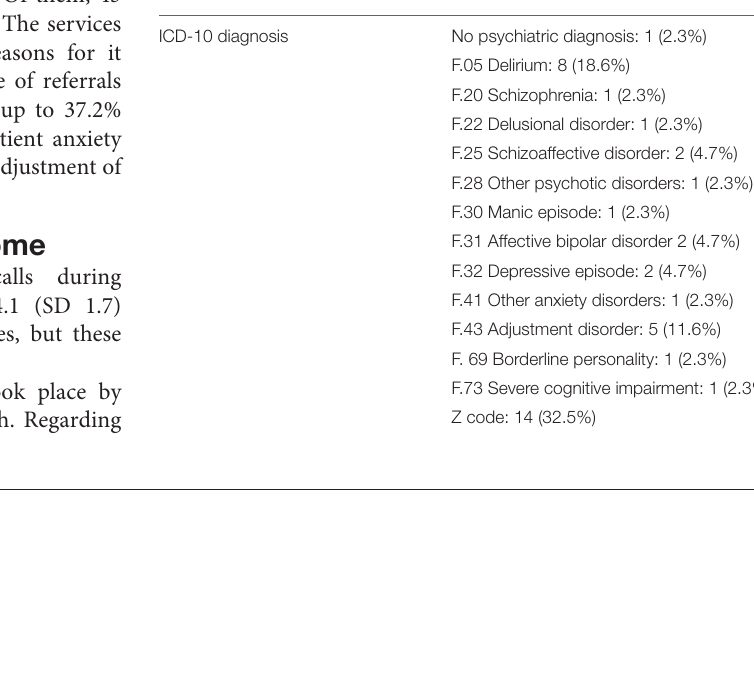
TABLE 2 | Psychiatric diagnosis after evaluation of the referrals.